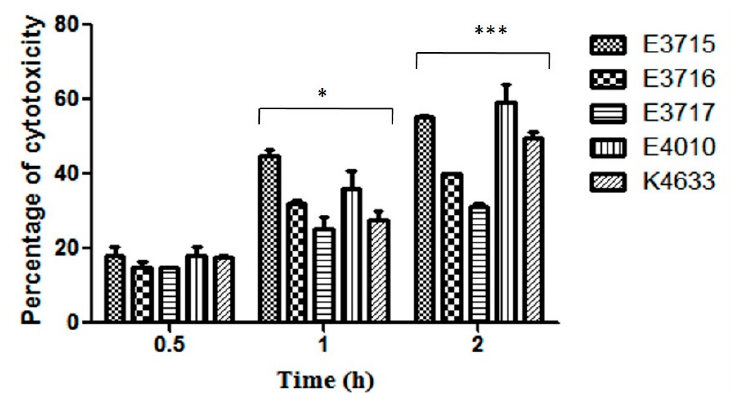
Figure 4. HeLa cells were infected with V. vulnificus at a multiplicity of infection (MOI) of 5. Percentage of cytotoxicity was measured at 0.5, 1, and 2 h of postinfection by LDH release assay. The data represents means and standard errors from three independent experiments. Factorial ANOVA was performed to analyze the difference between the strains (* p < 0.05 and *** p < 0.001).